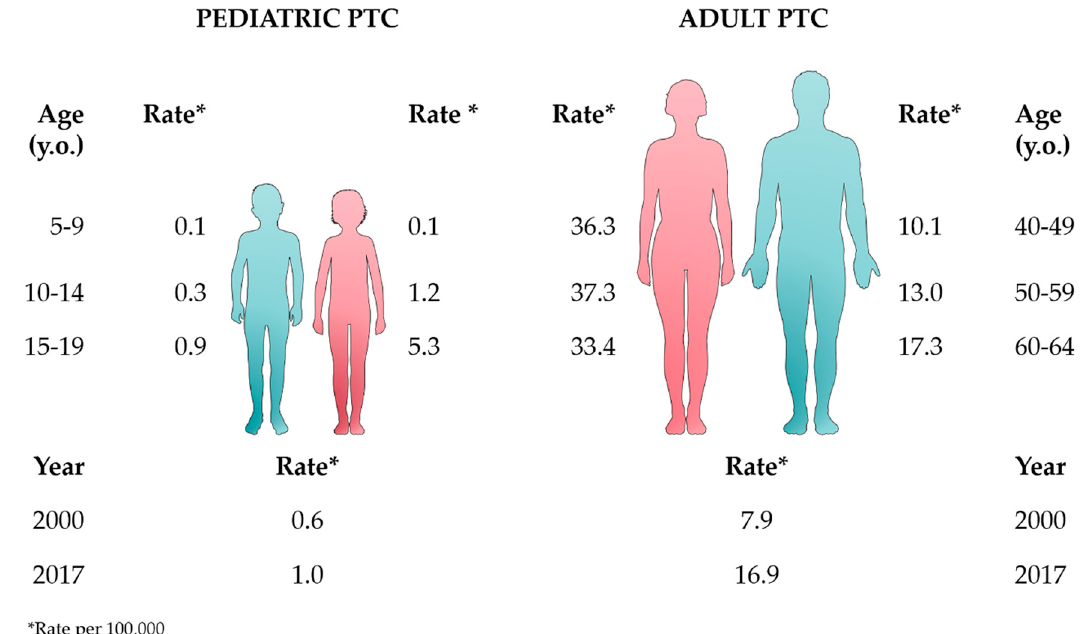
Figure 1. Epidemiologic data from the Surveillance, Epidemiology, and End Results (SEER) database (2000–2017) [19] comparing the rates of pediatric and adult papillary thyroid carcinoma (PTC) according to age, gender, and year. This figure was created using images from Servier Medical Art (http://smart.servier.com). Servier Medical Art by Servier is licensed under a Creative Commons Attribution 3.0 Unported License.